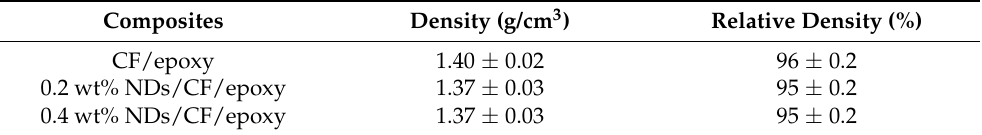
Table 1. Measured and relative density values of the CFRE-C specimens with and without